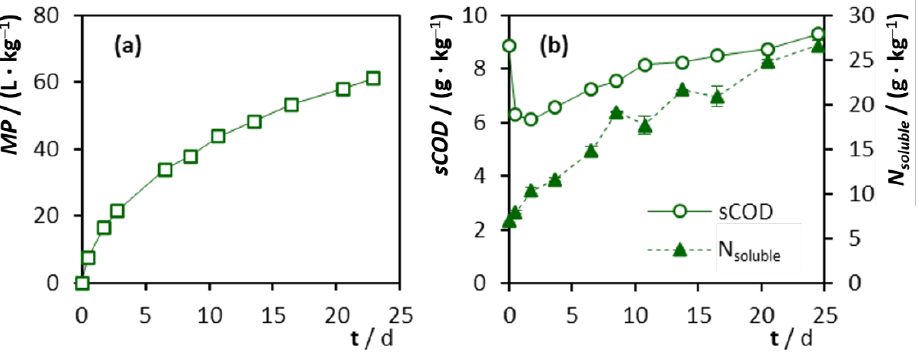
Figure 2. ( a ) Cumulative methane production (MP), ( b ) soluble COD (sCOD) and N soluble concentrations measured in the blank assays during the BMP test with dGS-5d. All parameters are expressed per kg of VS of inoculum.